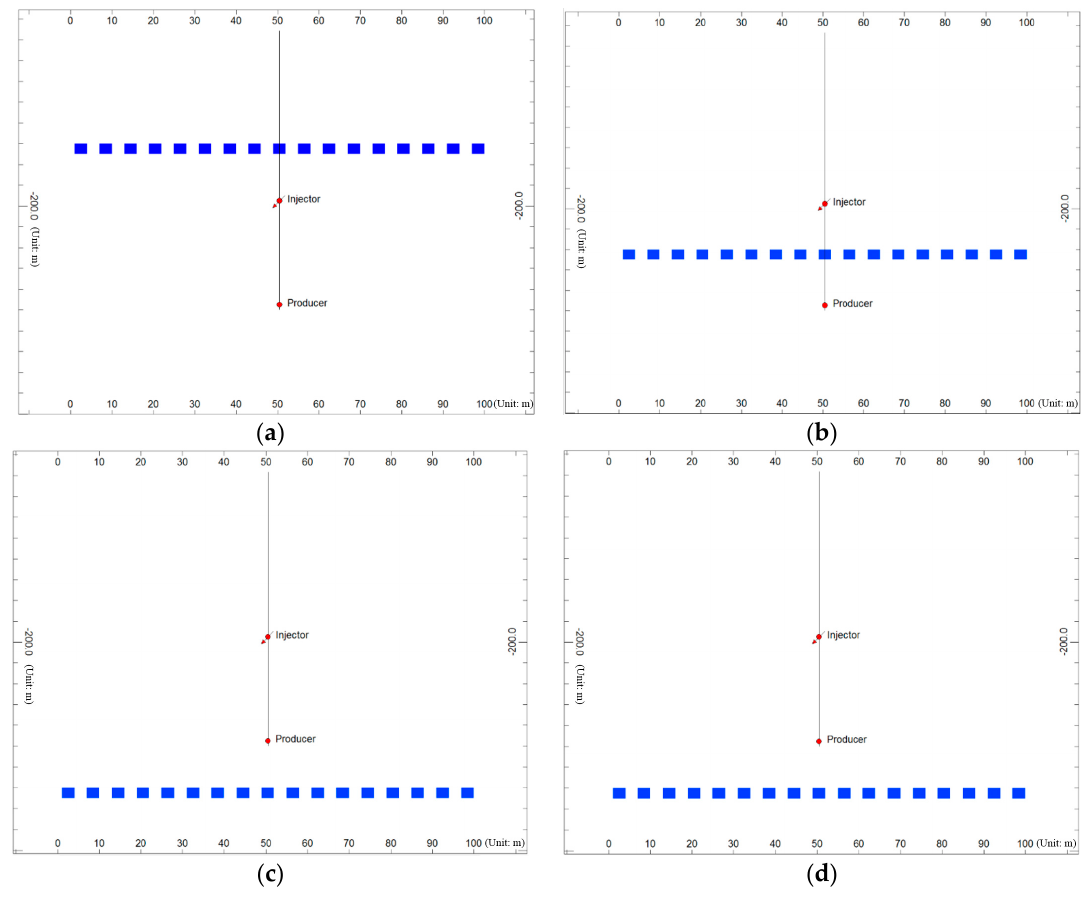
Figure 2. Distribution types of lean zones (( a ) AI type; ( b ) BIP type; ( c ) BP type; ( d ) multiple-layer).